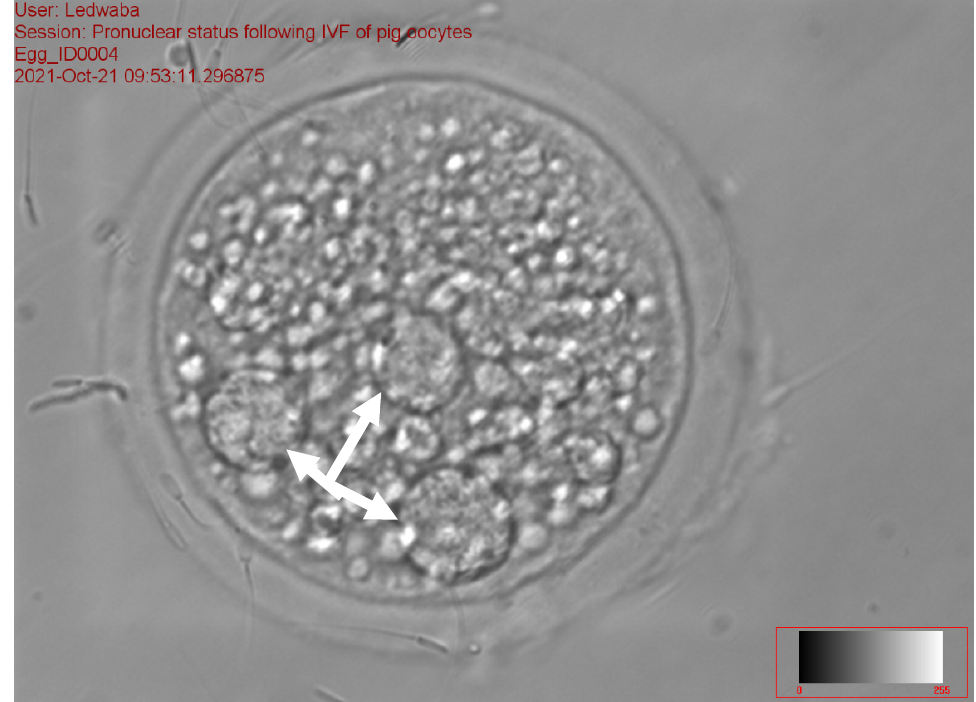
Figure 5. Zygote with the arrows showing >2 PN following in vitro fertilization at 40× magnification.